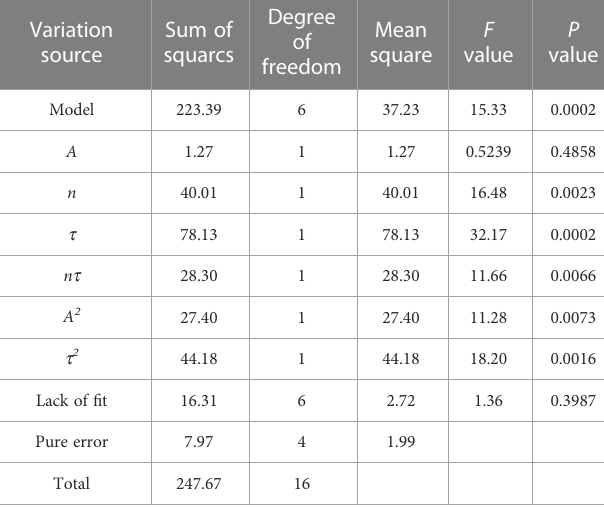
TABLE 8 ANOVA of coef fi cient of variation of shell fi sh